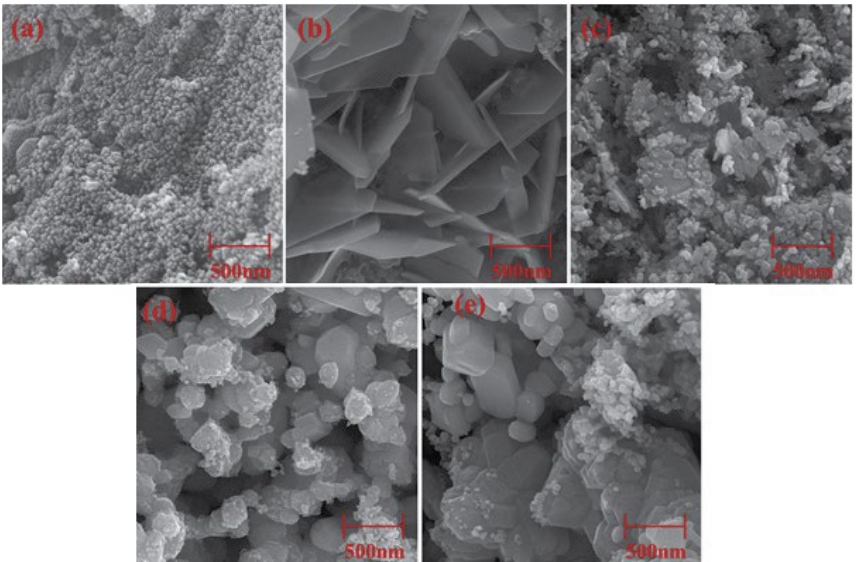
Fig. 5. FE-SEM images of different CdO–ZnO samples